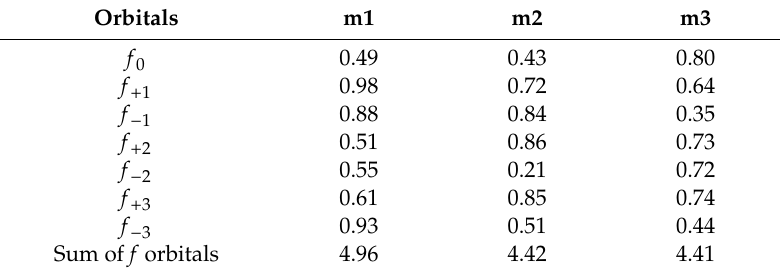
Table 2. Calculated atomic spin densities assigned to each f